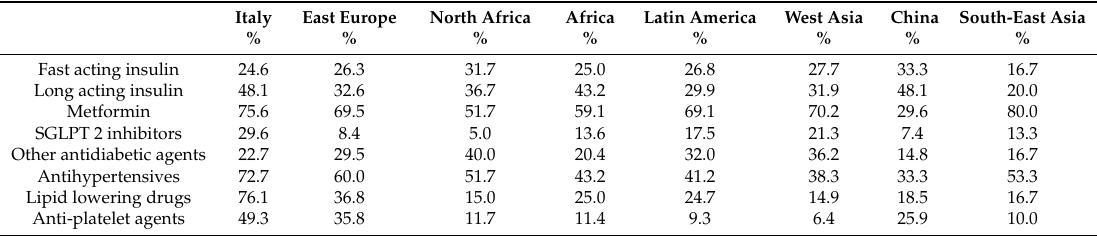
Table 3. Percentage of subjects on each class of medication in the di ff erent ethnic groups. Italy East Europe North